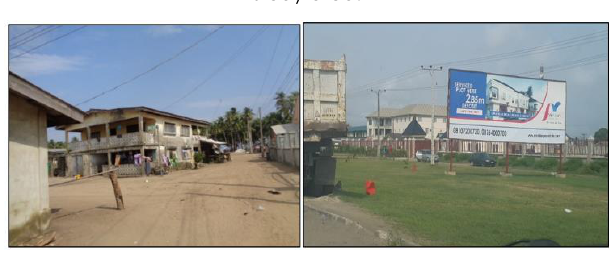
Figure 3. Mixed-type government-led housing scheme in the study area.